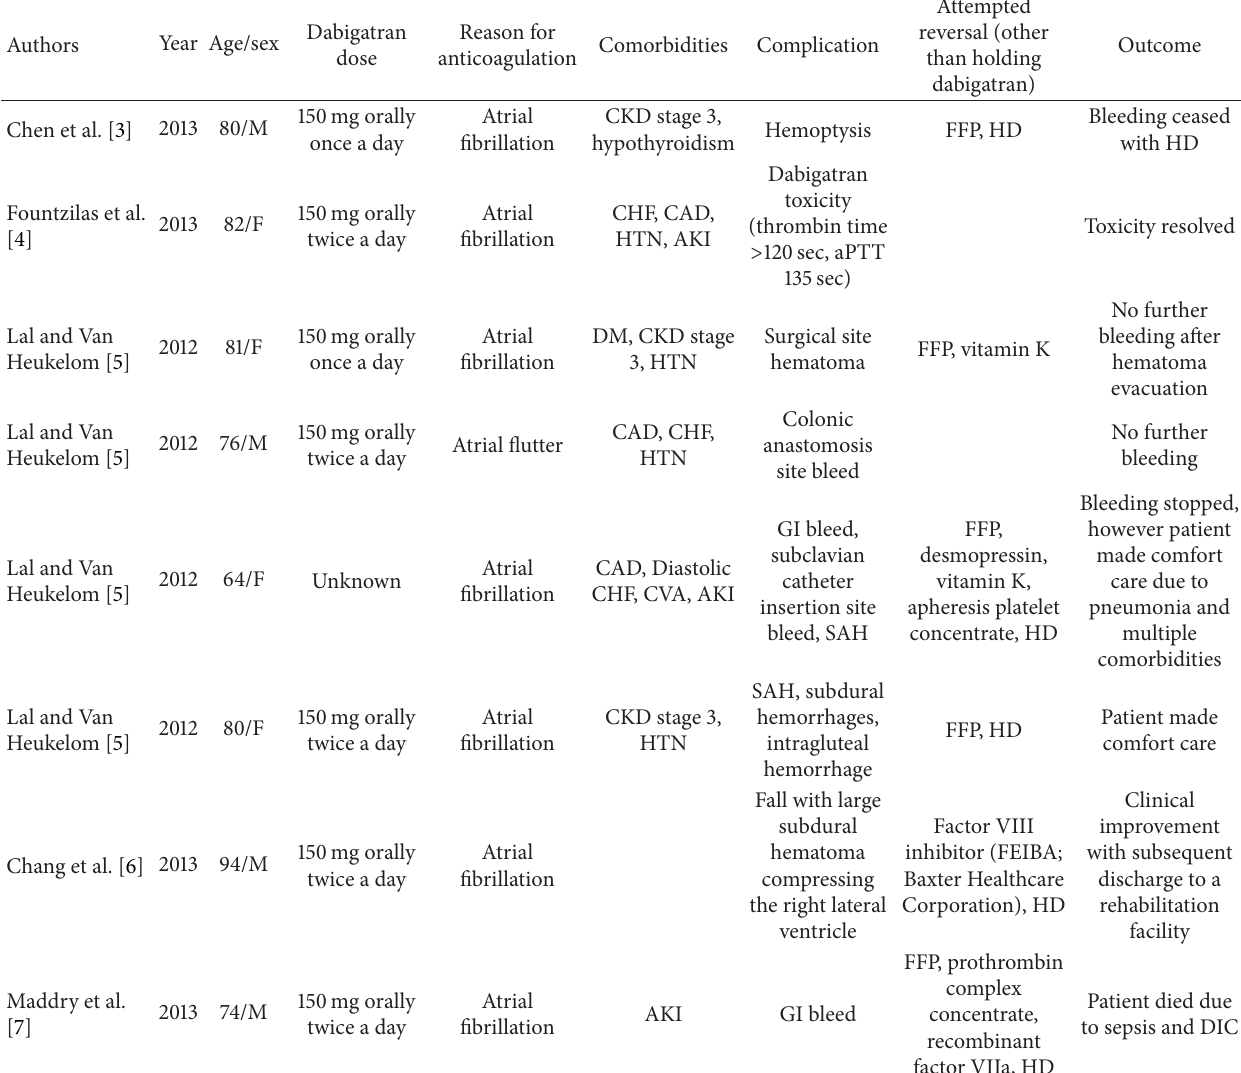
Table 1: Reported cases of dabigatran